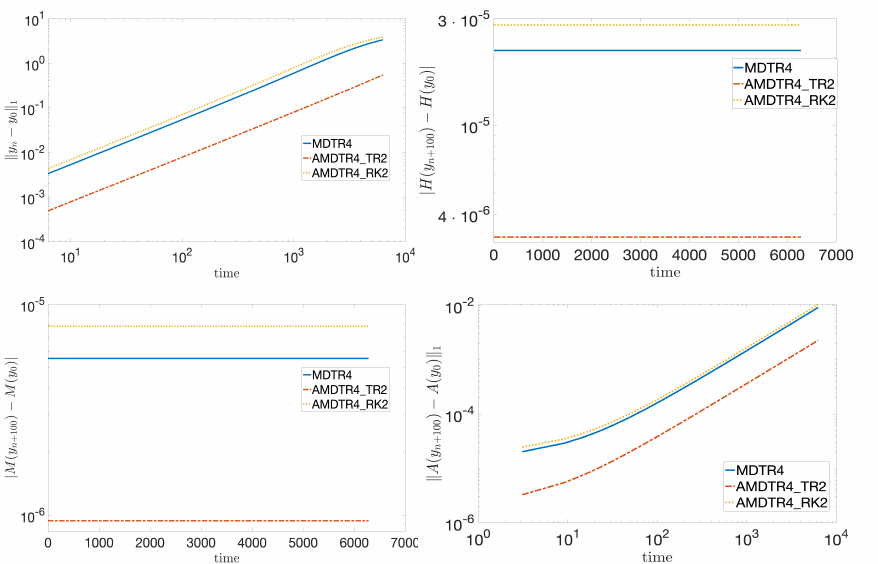
Figure 2. Results for the fourth-order MDTR (solid lines), Gauss (dashed lines), AMDTR_TR2 (dash- dotted lines) and AMDTR_R2 (dotted lines) methods applied to the Kepler problem computed at each